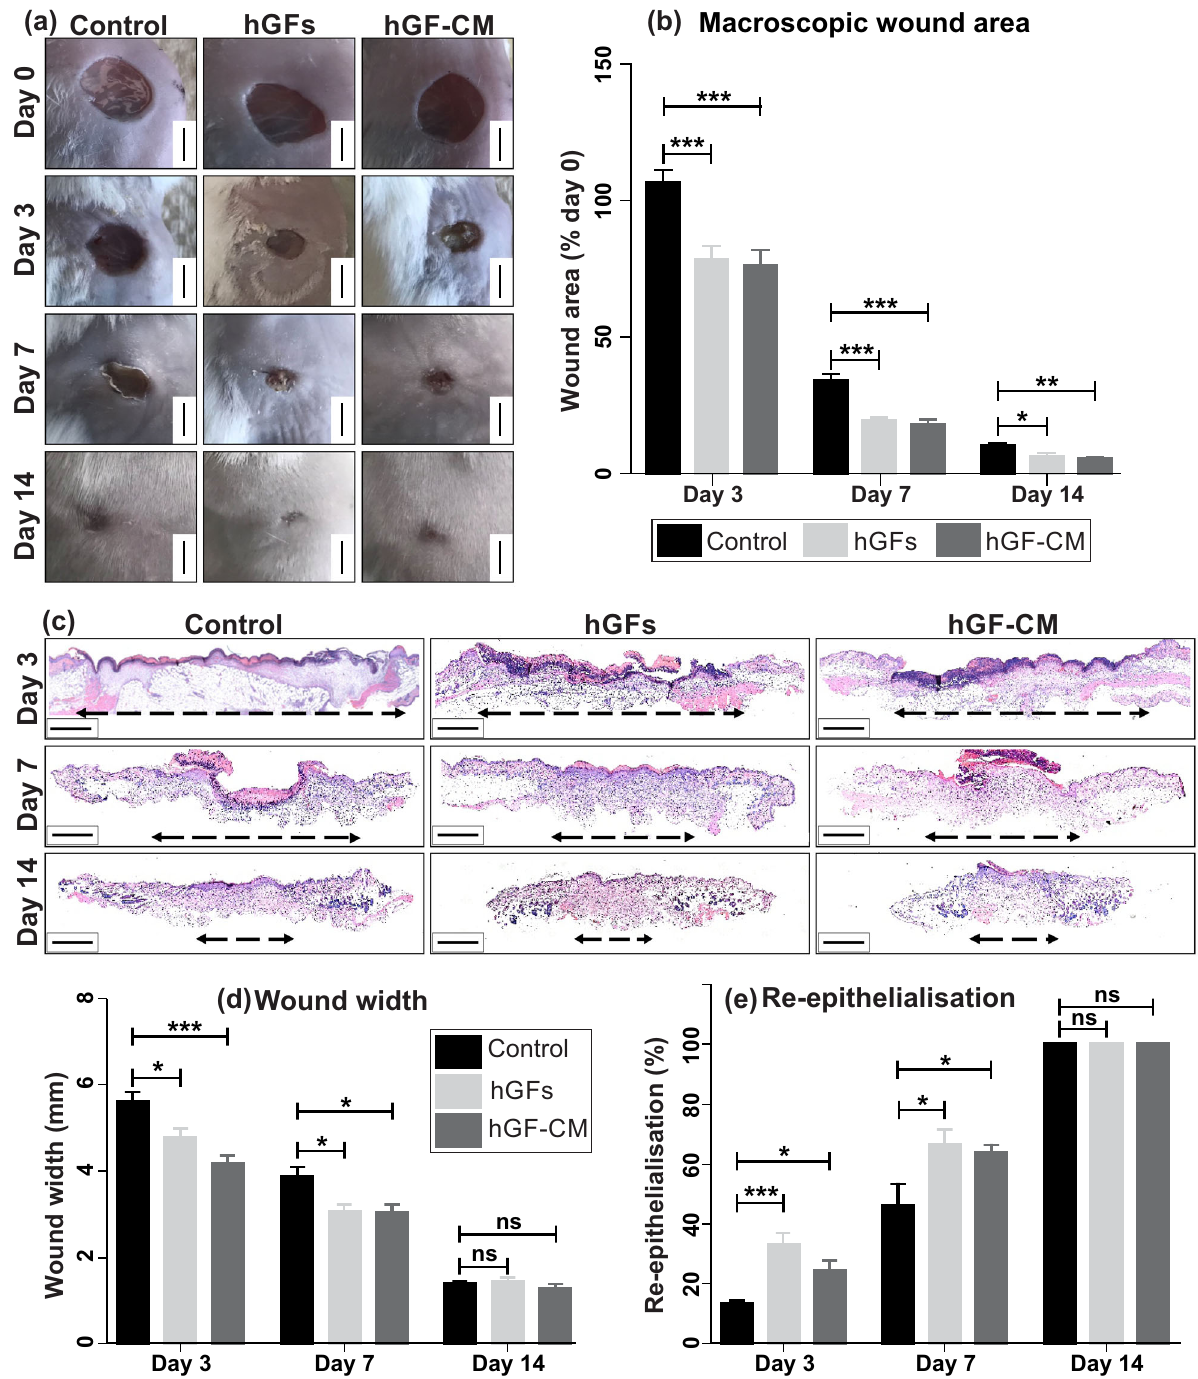
Fig. 1 The effect of hGFs and hGF-CM on excisional wound healing. a Representative images of hGF, hGF-CM treated wounds at days 3, 7 and 14 of healing. Scale bars represent 5 mm. b Macroscopic area of excisional wounds at days 3, 7 and 14. n = 8. c Representative images of H&E stained wounds at days 3, 7 and 14 of healing. Scale bars represent 1 mm. d Histological wound width and e average re-epithelialisation of excisional wounds at days 3, 7 and 14. Images captured at ×10 objective. Black dashed lines indicate wound width. n = 8. f All data is represented as mean ± SEM. * p < 0.05, ** p < 0.01, *** p < 0.001, ns = nonsigni fi